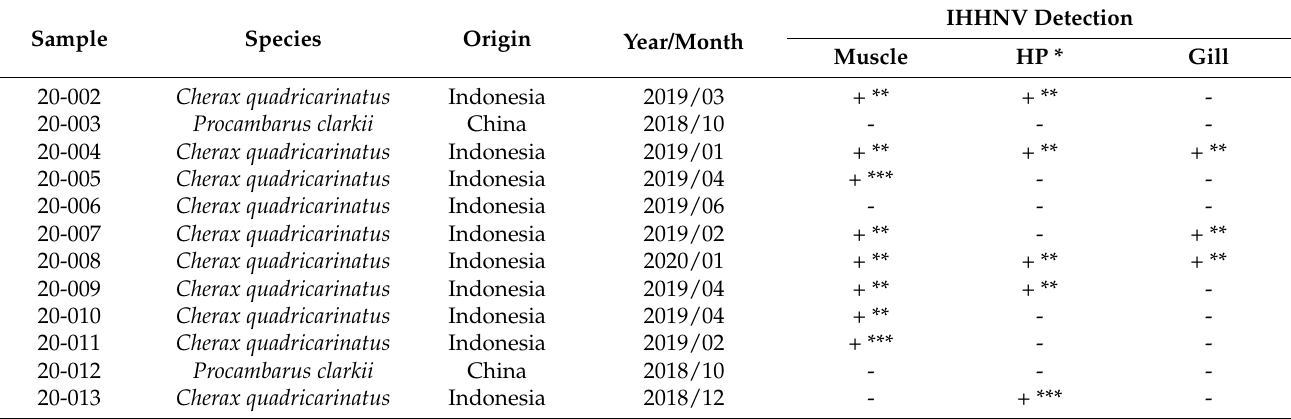
Table 1. Crayfish species, country of origin, year collected, and PCR detection of IHHNV in DNA extracted from each of three different tissue types pooled from each batch of